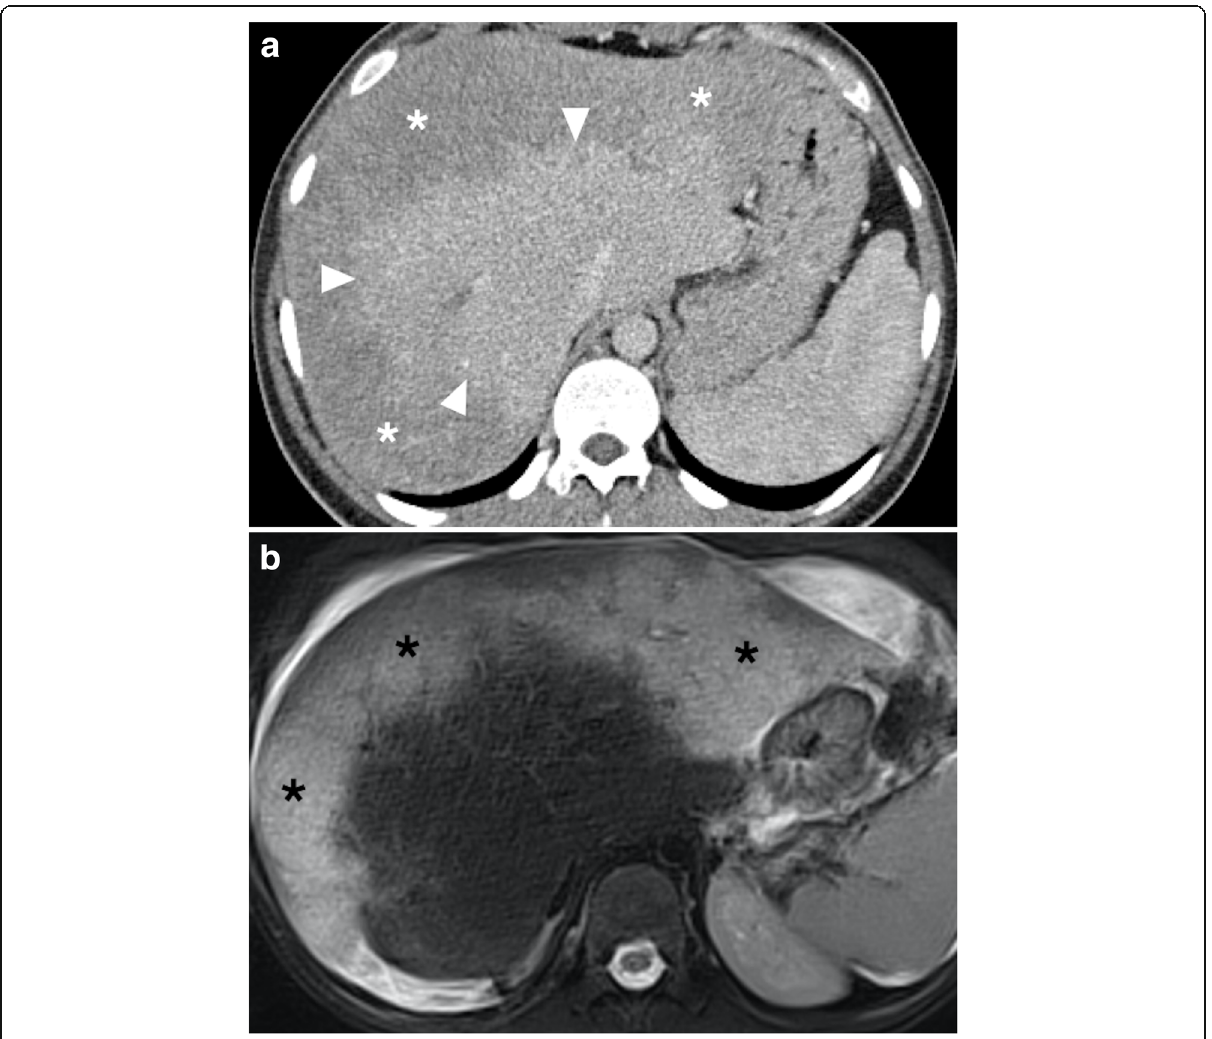
Fig. 8 Budd-Chiari syndrome. A 23-year-old male with factor 5 Leiden mutation presented with acute epigastric pain and elevated liver enzymes. Abdominal US study demonstrated fresh thrombus in the hepatic veins and hepatomegaly. a Axial plane post-contrast CT image showed reduced perfusion within the periphery of the hepatic parenchyma (asterisks) with relatively normal enhancing central parenchyma (arrowheads). b Axial T2W MR image shows diffuse edema and congestion within the peripheral portion of the liver parenchyma (asterisks) which corresponds to non-enhancing liver parenchyma on